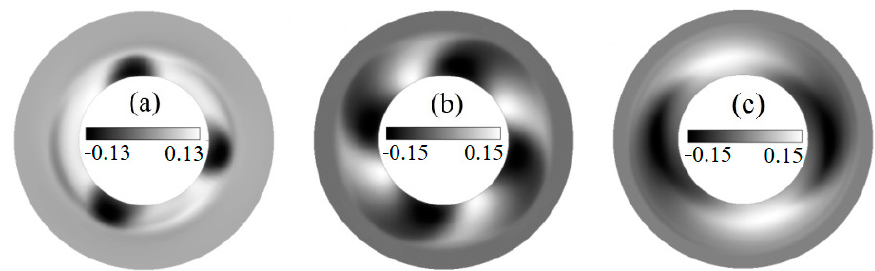
Figure 8. Overview of surface solute concentration fluctuations at Re s = 0 and Re T = 10 4 . ( a ) Re c = 9.4 × 10 2 ; ( b ) Re c = 1.4 × 10 3 ; ( c ) Re c = 2.3 × 10 3 .